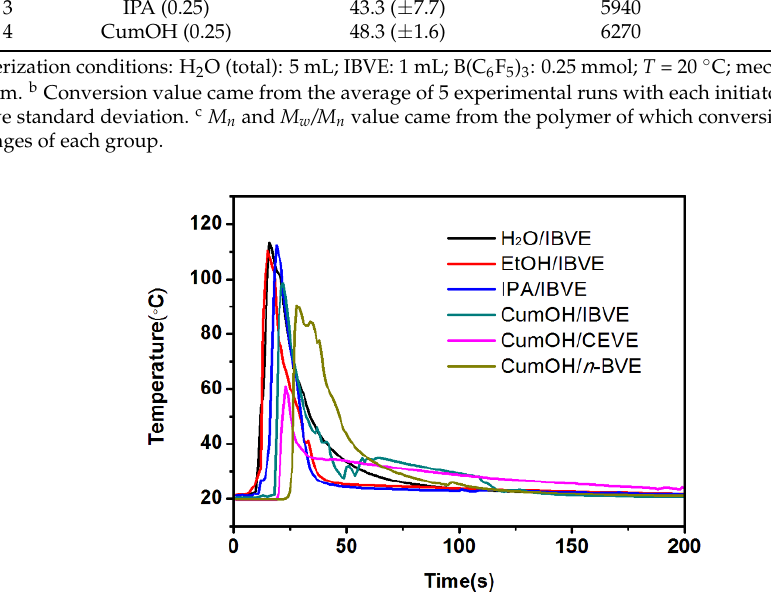
Figure 2. Temperature during cationic polymerizations of vinyl ethers initiated by different alcohols/B(C 6 F 5 ) 3 /Et 2 O in aqueous suspensions at 20 ◦ C: [IBVE] = 1.6 M; [CEVE] = 2.0 M; [ n -BVE] = 1.6 M; [EtOH] = [IPA] = [CumOH] = 0.05 M; [B(C 6 F 5 ) 3 ] = 0.05 M; [Et 2 O] = 0.1 M. CEVE: 2-chloroethyl vinyl ether; n -BVE: n -butyl vinyl ether; IPA: